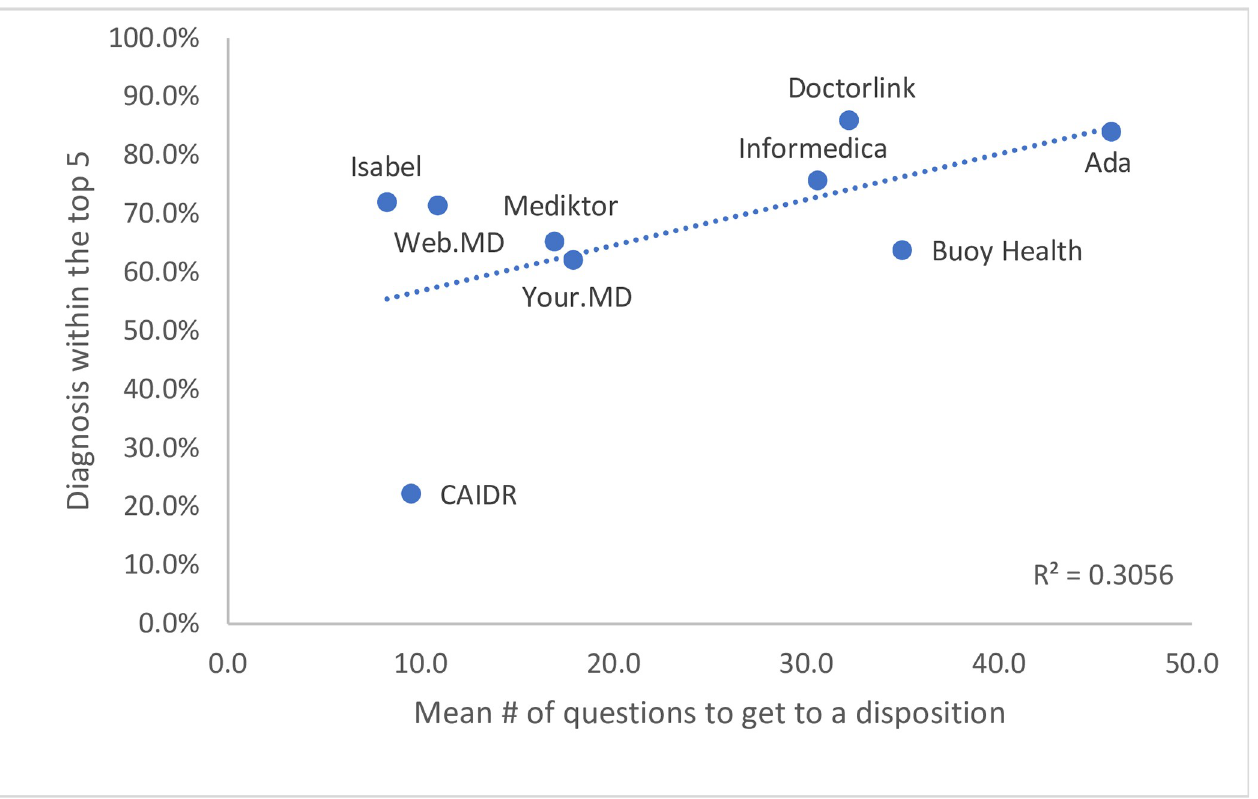
Fig 2. Correlation of mean number of questions to diagnostic accuracy listed in the top five.